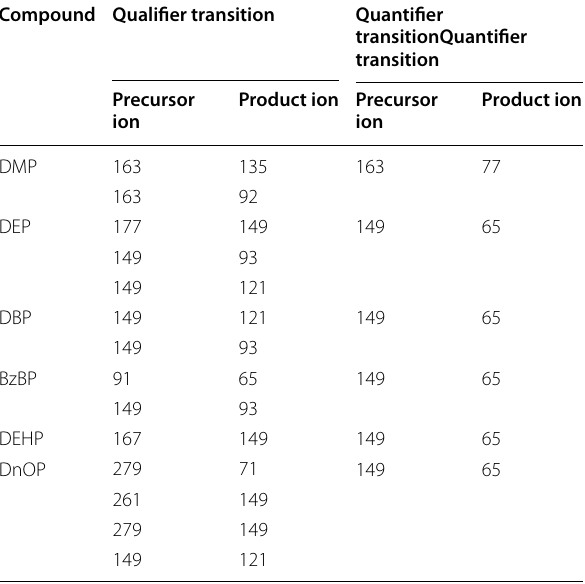
Table 1 Qualifier and quantifier transitions of the six phthalates in the mass spectrometry detector